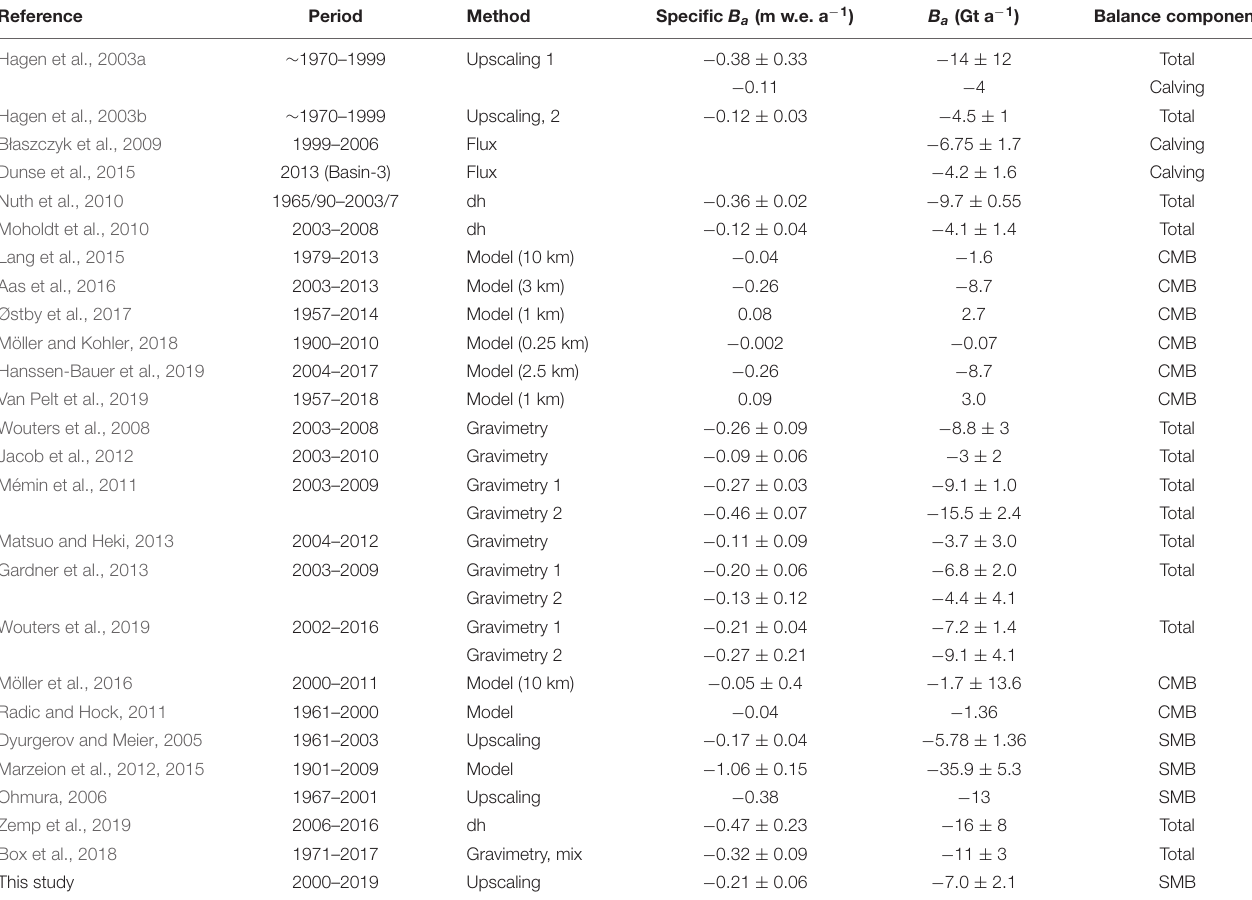
TABLE 2 | Comparison of several Svalbard-wide estimates of annual glacier mass balance B a using different